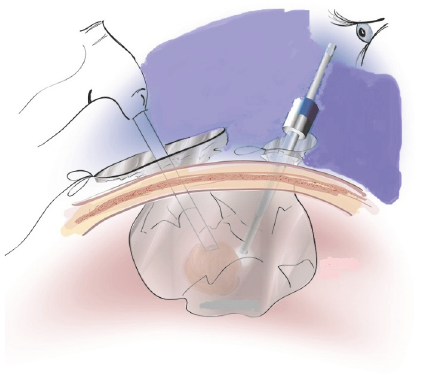
Figure 1: Isolated bag.